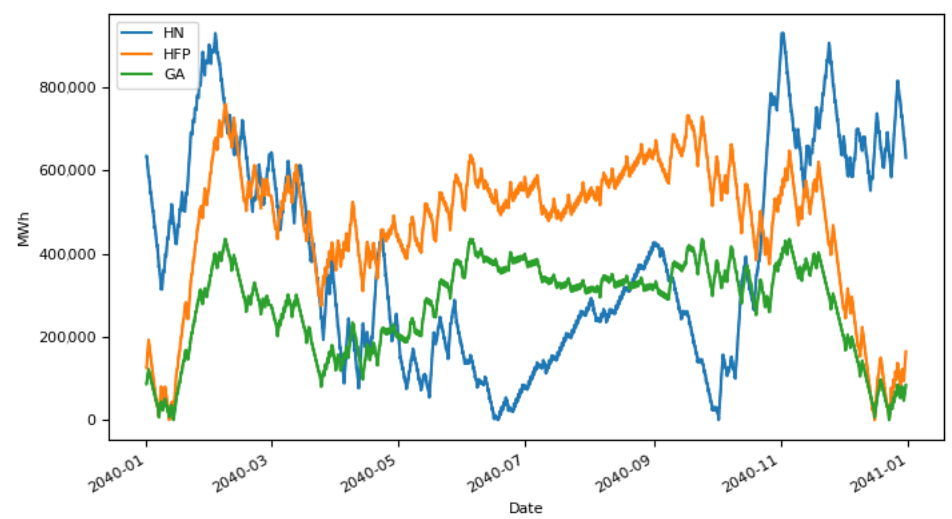
Figure 7. Trajectories of the state of charge of the underground Hydrogen storage for the 2040 scenarios—GA (green), HFP (orange) and HN (blue).